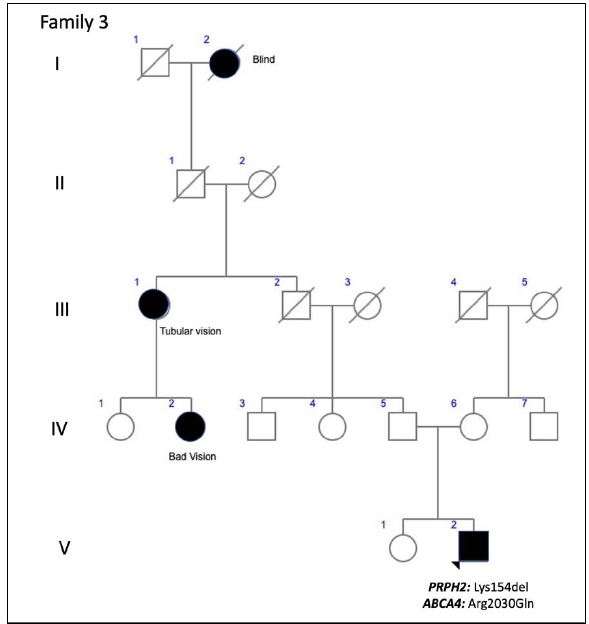
Figure 8. The family 3 pedigree shows apparent non-penetrance.